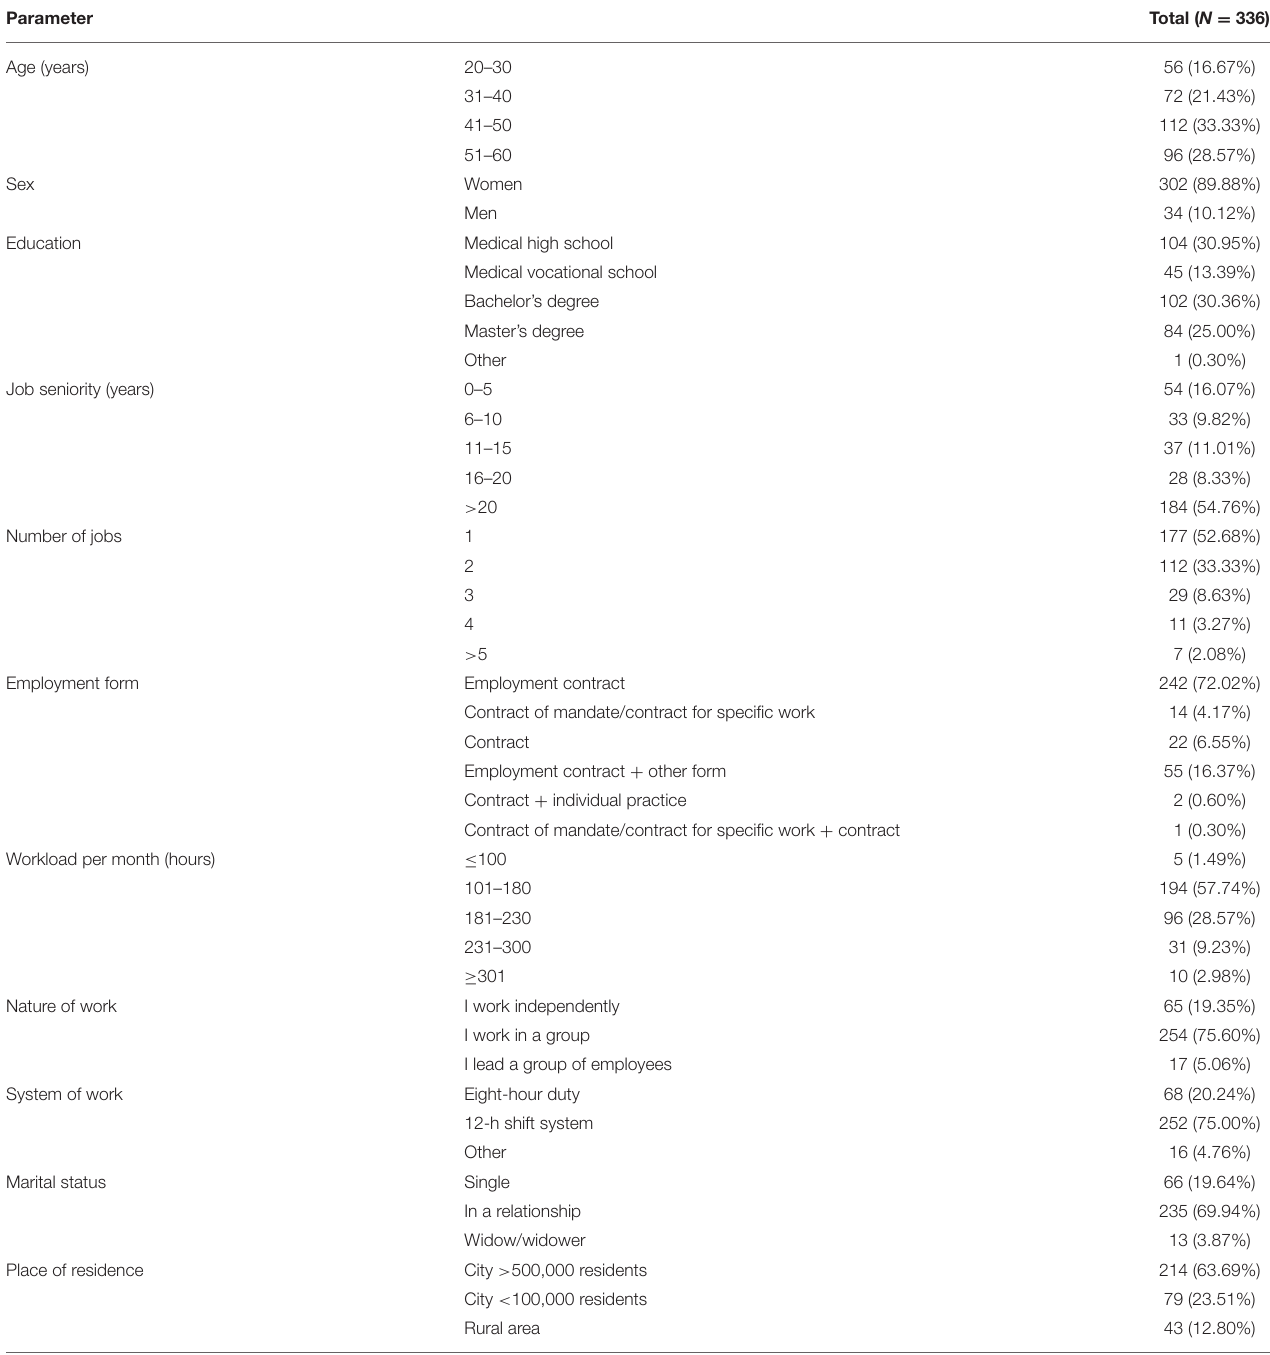
TABLE 1 | Sociodemographic characteristics of surveyed cardiac nurses.